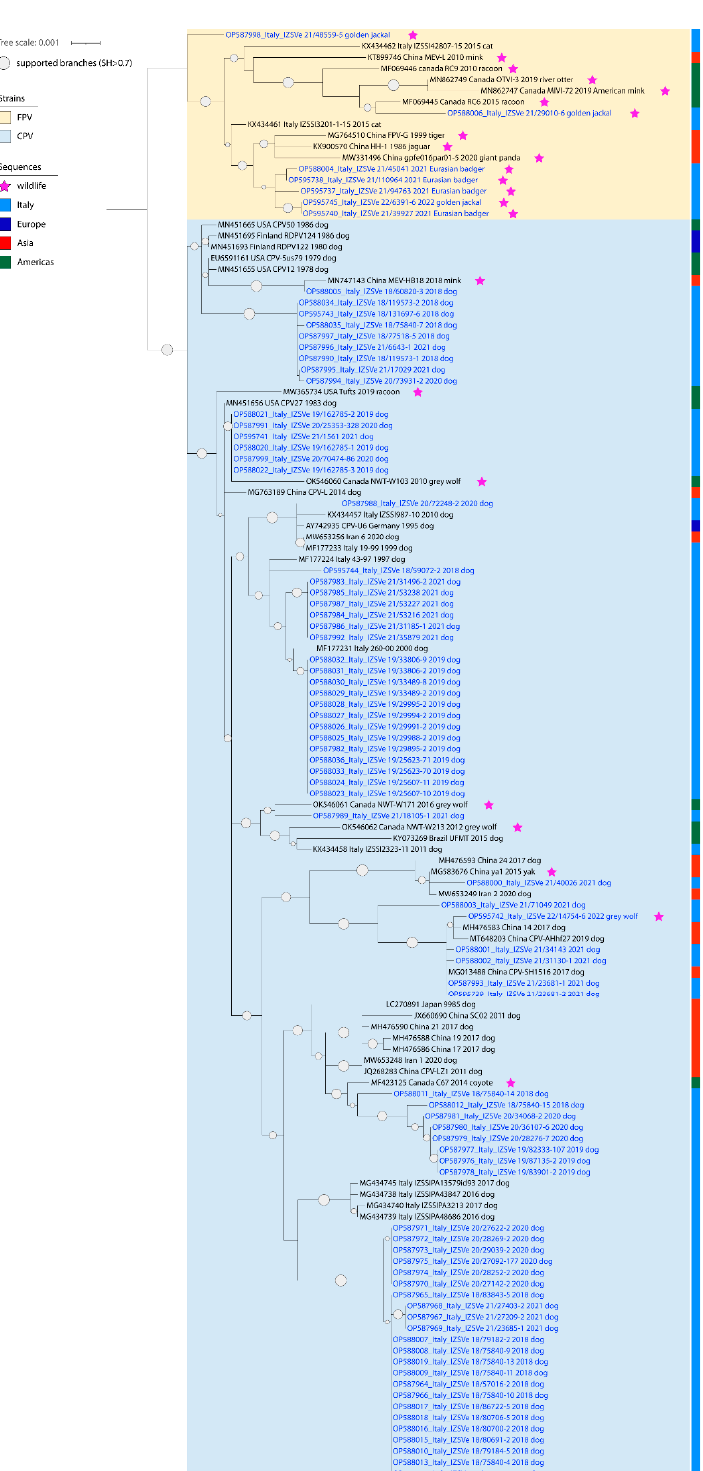
Figure 2. ML phylogenetic tree of Protoparvovirus 1 analyzed in this study, based on the complete genome, divided in canine (blue) and feline (yellow) parvoviruses. Branches supported with SH value higher than 0.7 are marked with grey circles, with size proportional to the SH value. Original strains sequenced for this work are shown with blue labels. Sequences (original and reference) associated with wildlife and found in the study area are indicated with pink